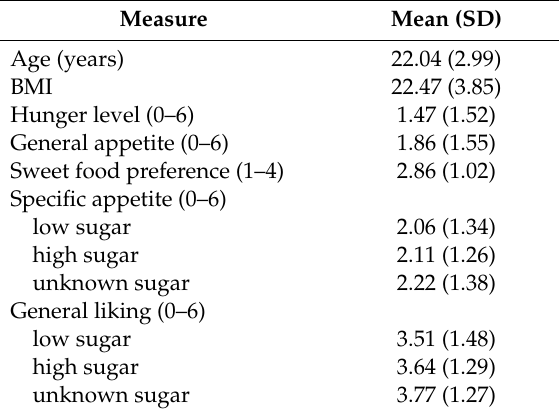
Table 1. Sample characteristics and rating